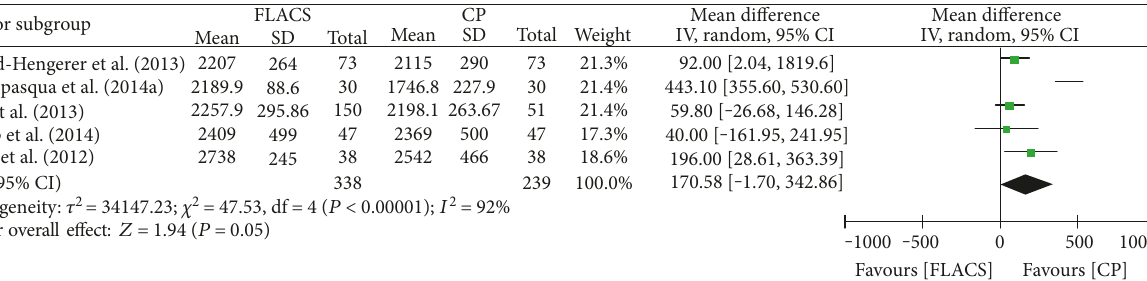
Figure 3: Forest plots displaying the e ff ect of femtosecond laser-assisted cataract surgery (FLACS) versus conventional phacoemulsi fi cation cataract surgery (CPCS) on corneal endothelial